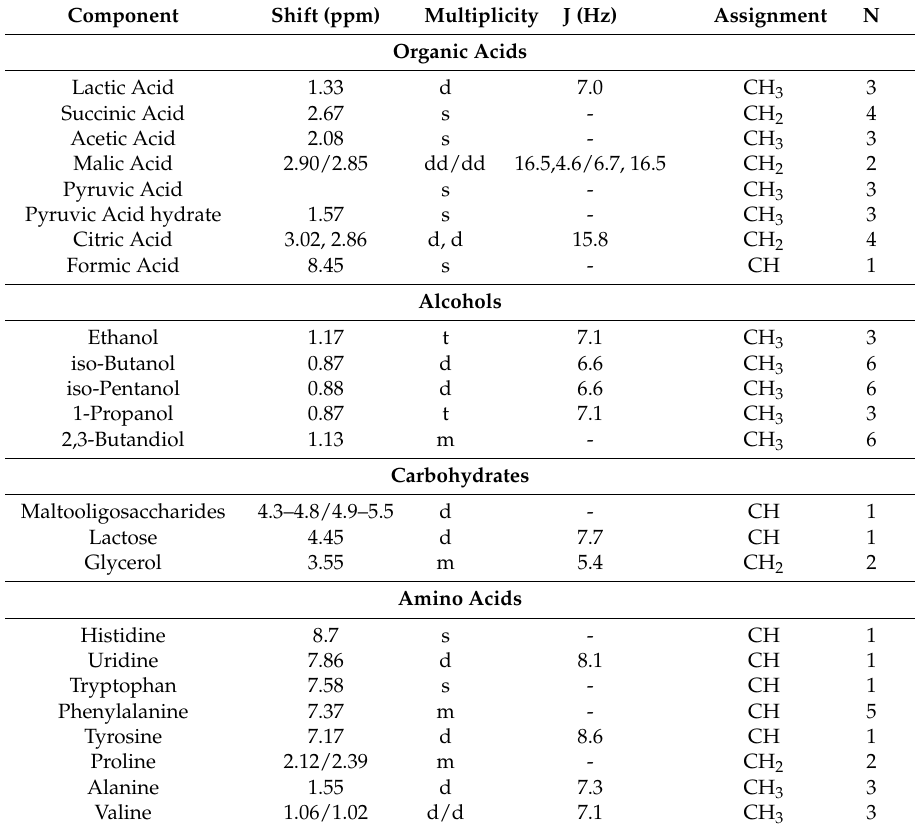
Table 2. Assignment of unique marker signals for each molecular component quantified in the beer